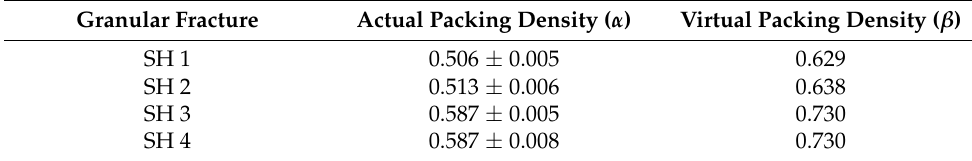
Table 3. Values of actual and virtual packing densities for different monodispersed